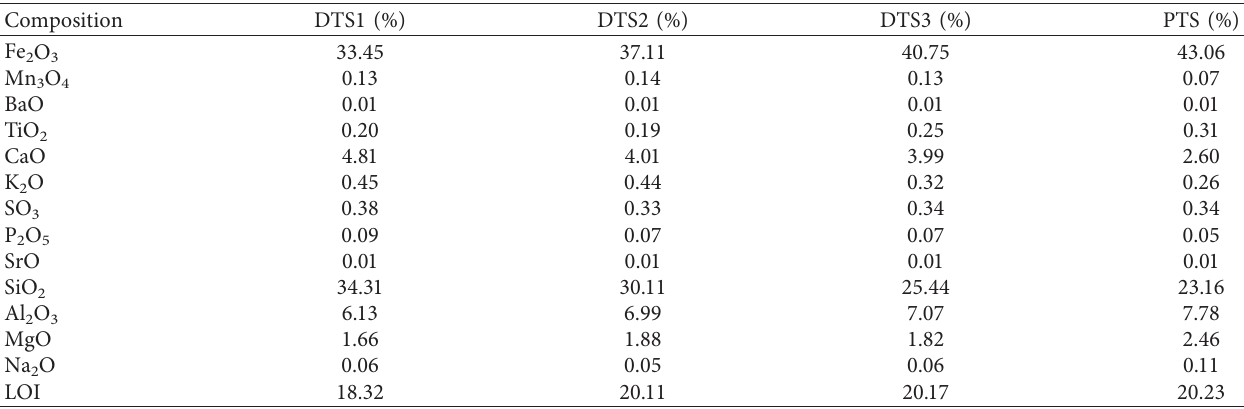
Table 2: Tailings’ chemical properties (oxide analyses).